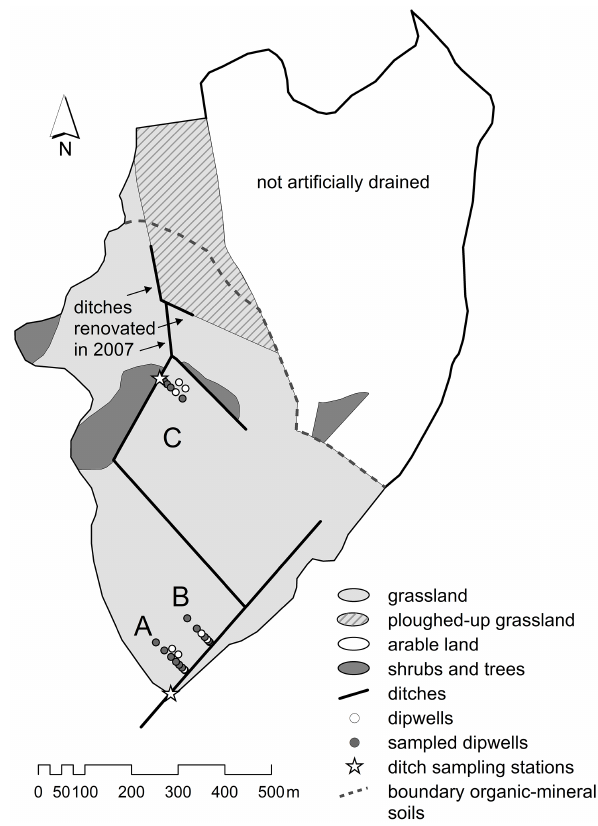
Figure 1. The study